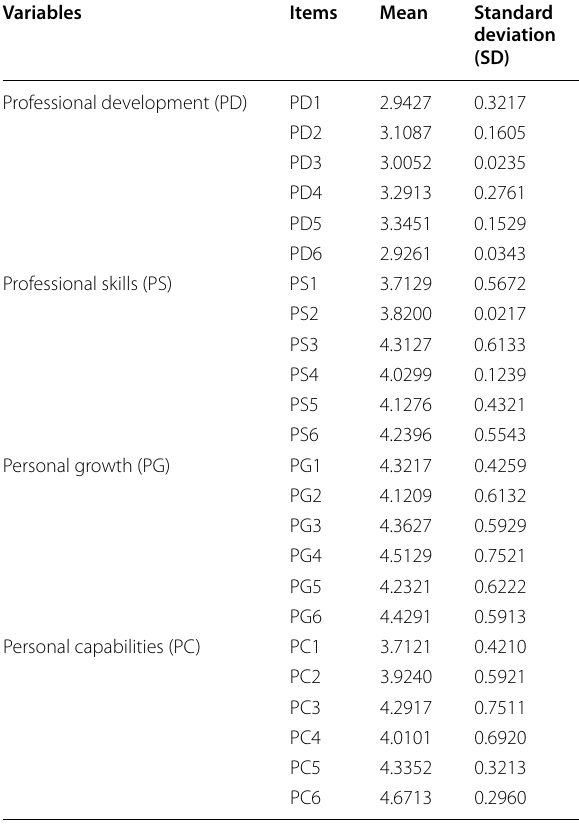
Table 5 Reliability analysis Source : developed for